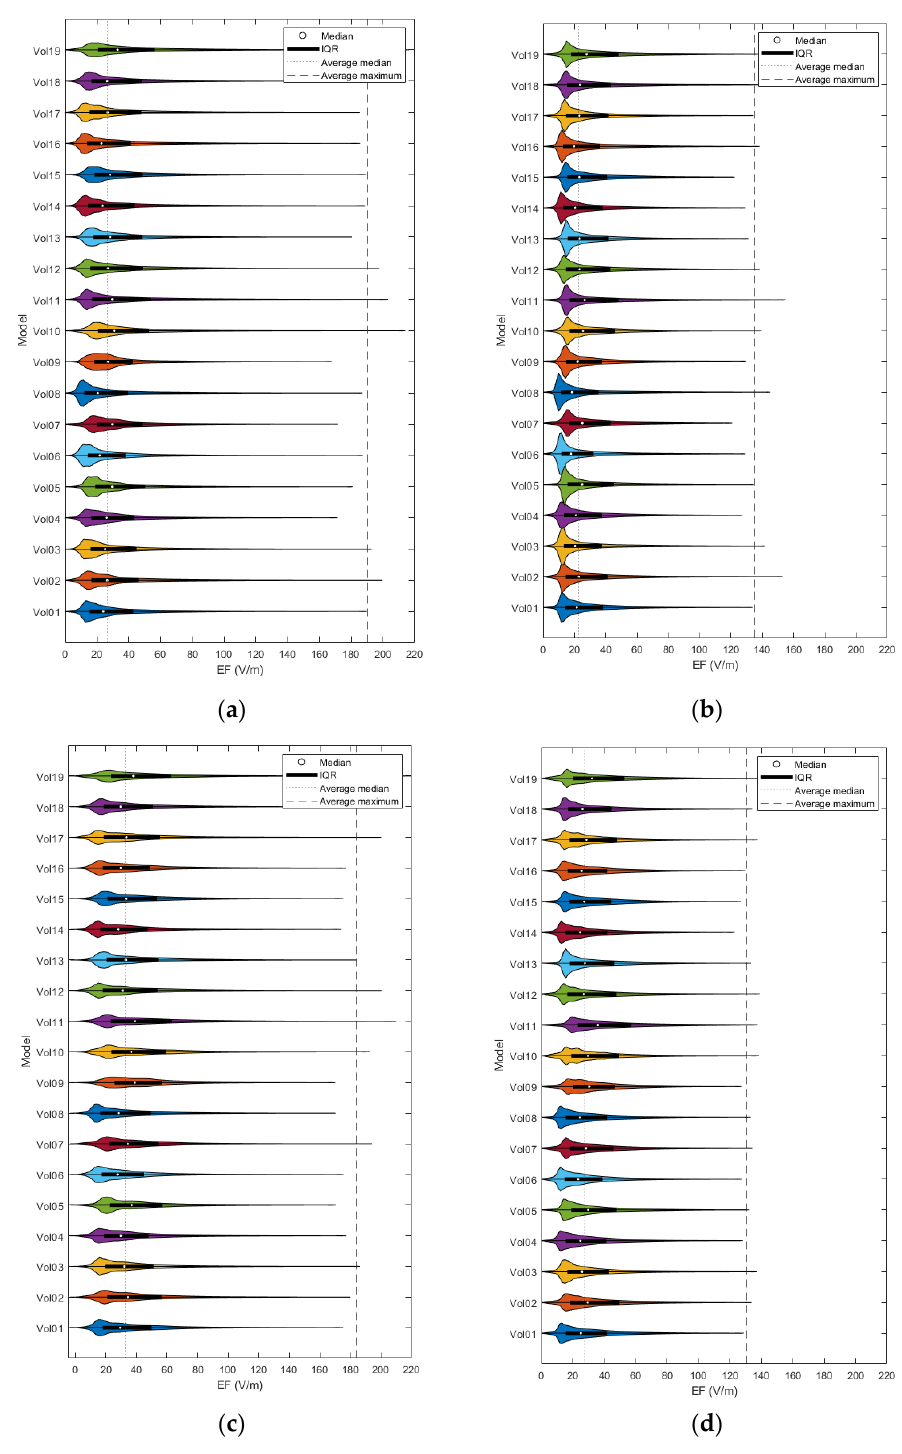
Figure 3. Violin plots and IQRs of the EF distributions for frontal coil positioning on anatomical ( a ) and homogeneous ( b ) models, and central positioning on anatomical ( c ) and homogeneous ( d ) models.